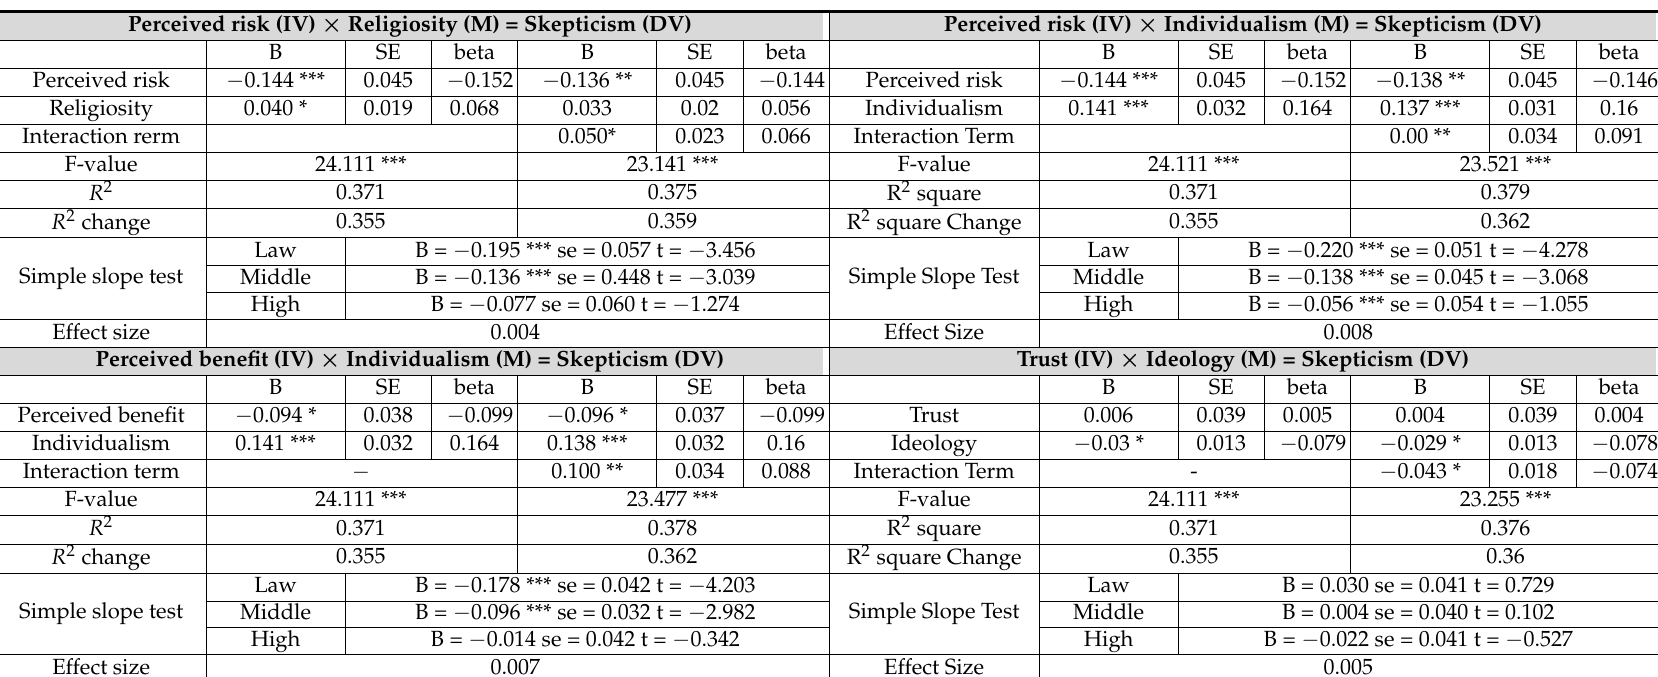
Table A1. Analysis of interaction effect and simple slope